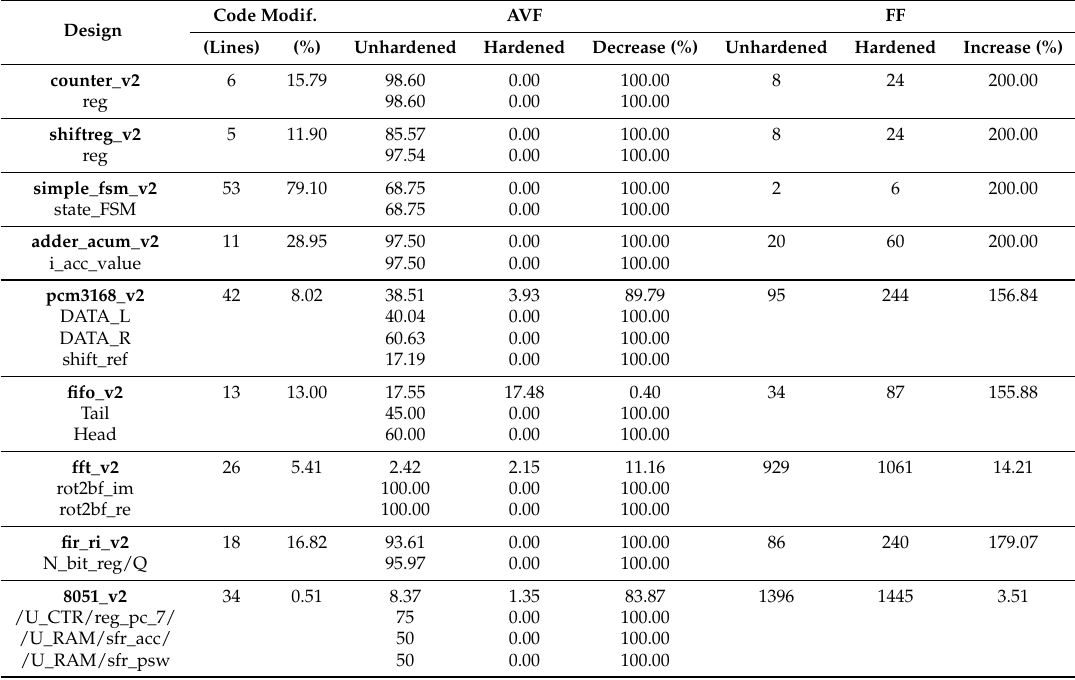
Table 7. Hardened versions of the designs under test, synthesized with Synplify.